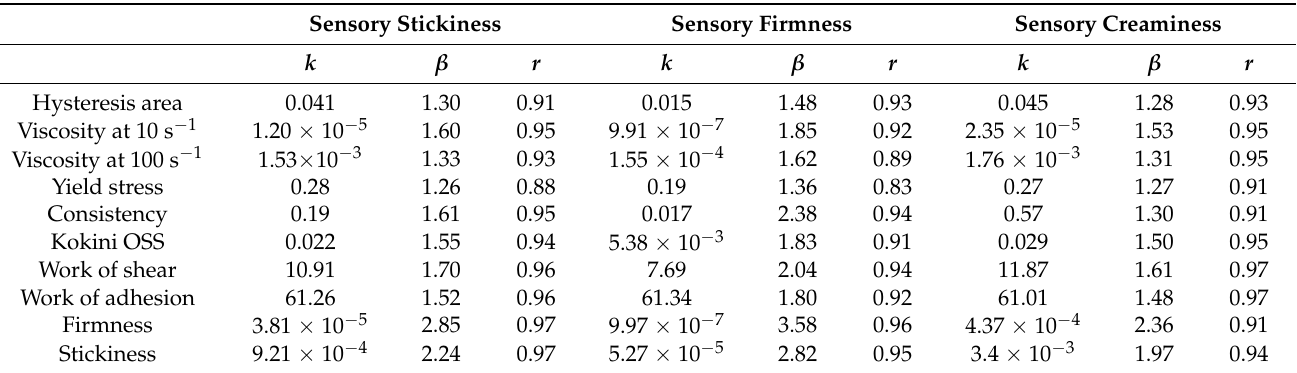
Table 6. The relationship between sensory and instrumental data using Stevens’ law, with the constant k , the exponent β , and the correlation coefficient r .